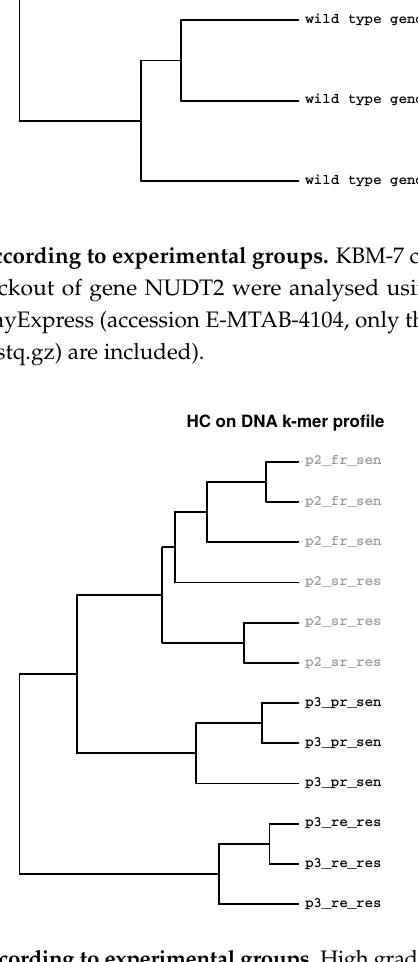
Figure 3. Clustering according to experimental groups. High grade serous ovarian carcinoma cells from two patients were characterised using whole genome sequencing. Leaf labels indicate patient (p2 and p3), clinical status (fr = first relapse, sr = second relapse, pr = primary presentation, re = relapse)